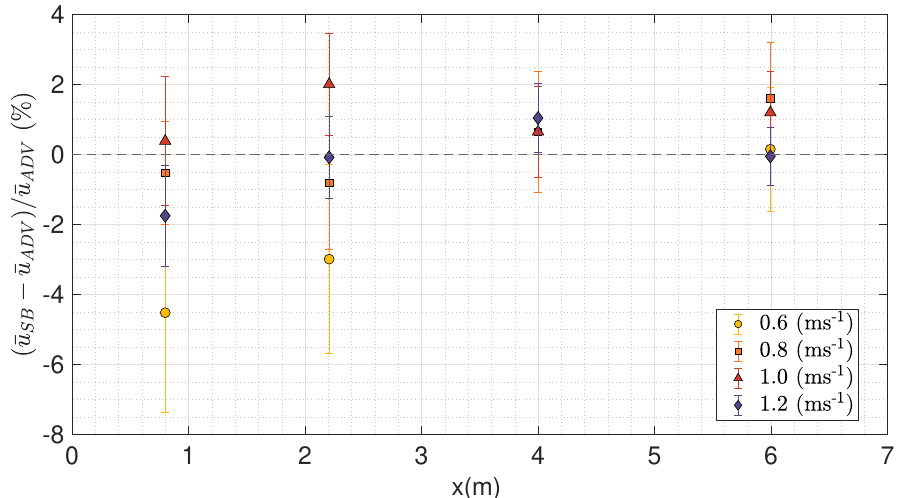
Figure 9. Relative bias in mean velocity measurement between the SB-ADP and the ADV as a percentage of the velocity measured by the ADV. The co-located SB-ADP and ADV measurements along the all profile were used for the tank nominal flow velocity of 0.8 ms − 1 . At the target locations A, B, C and D,for the nominal tank flow velocity of 0.6 ms − 1 , 1.0 ms − 1 and 1.2 ms − 1 , measured velocity of the measurement cells n 1 n 2 overlapping at the ADV measurement location were